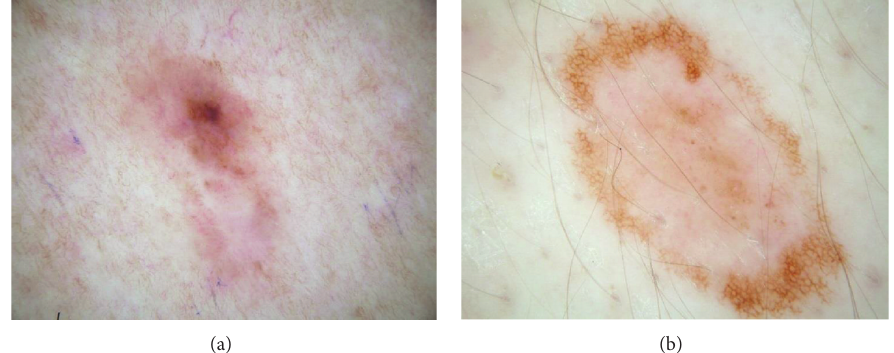
Figure 3: (a) Invasive melanoma, 8 mm wide, back, 62-year-old female, depth 0.55 mm. Nearly circumferential peripheral and central pink.